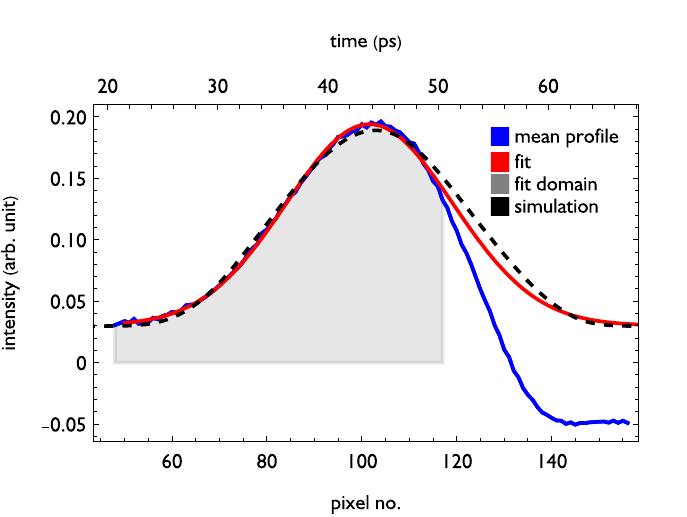
Figure 5. ( a ) Removal of the Gotthard chip dependent offset from the measured data. ( b ) Definition of the region of interest. Details see main text.